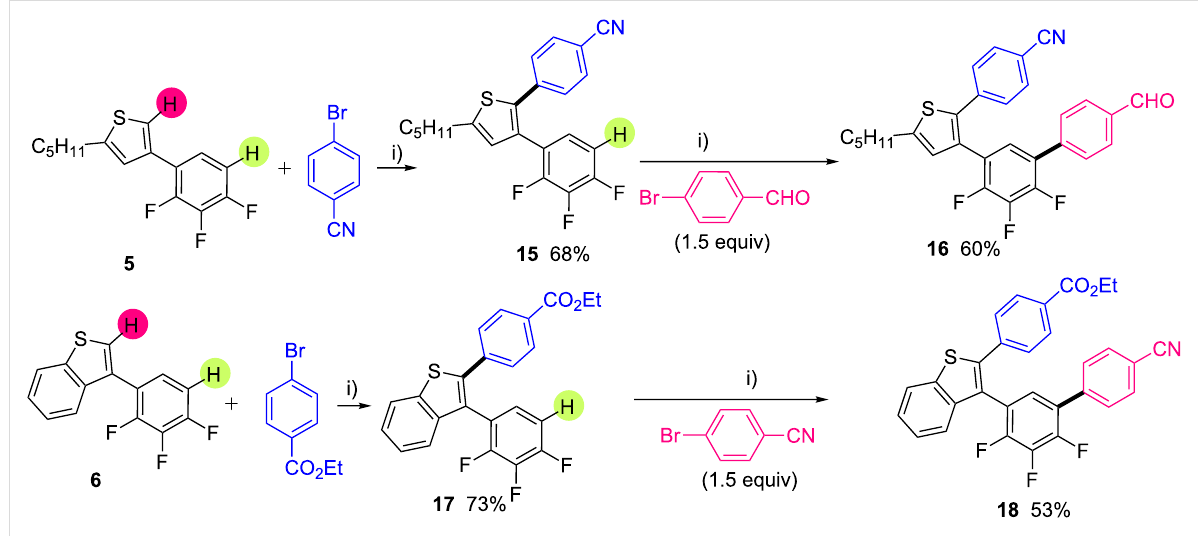
Scheme 4: Pd-catalyzed direct regioselective arylation of 3-(2,3,4-trifluorophenyl)thiophenes. i) PdCl(C 3 H 5 )(dppb) (2 mol %), KOAc (2 equiv), DMA, 150 °C, 16 h.